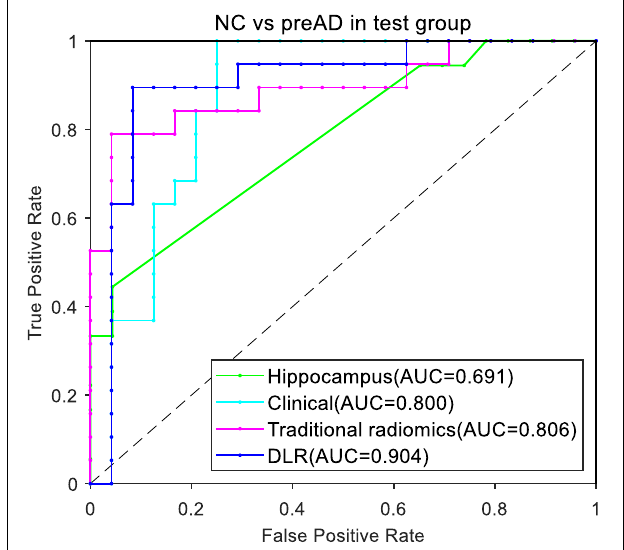
FIGURE 4 | ROC curves of the four models between NC and preAD groups.